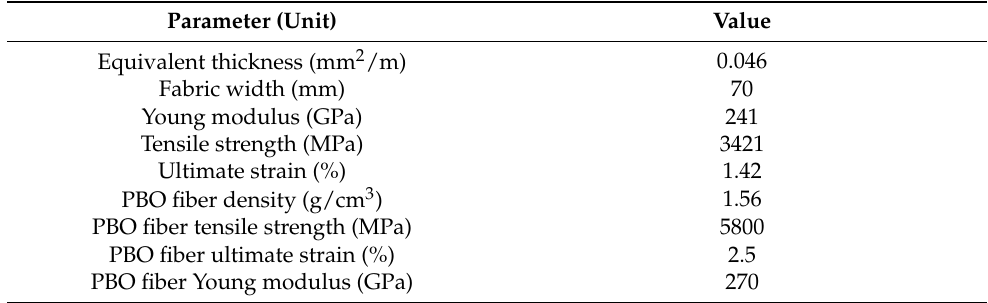
Table 1. Mechanical and geometrical properties of PBO-fabric reinforced cementitious mortar (FRCM) composite system (fibers + matrix).